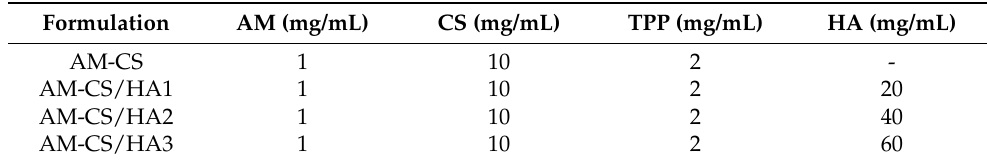
Table 1. AM nanoparticles’